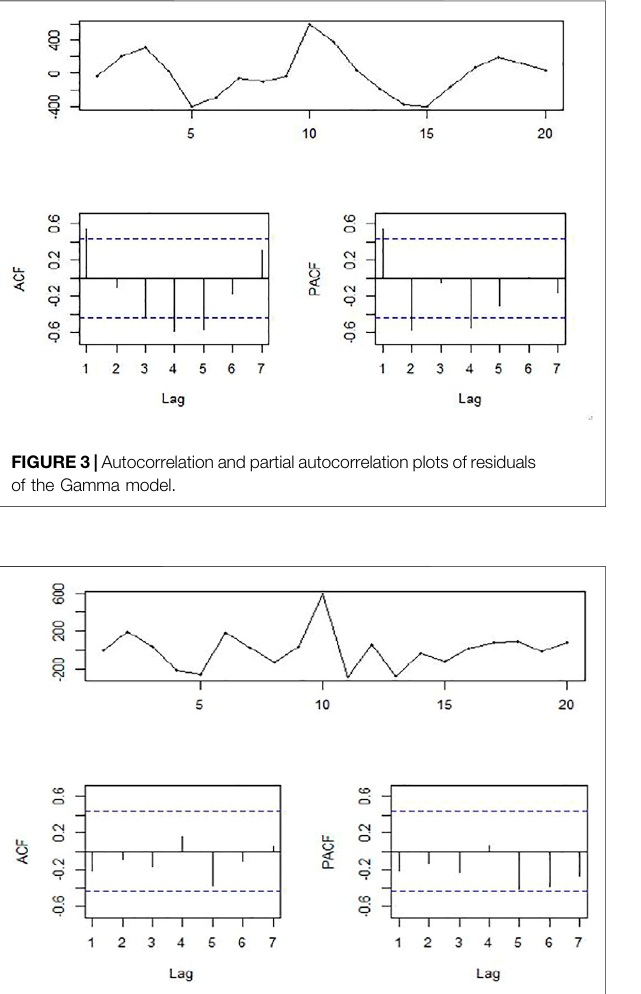
Frontiers in Environmental Science |